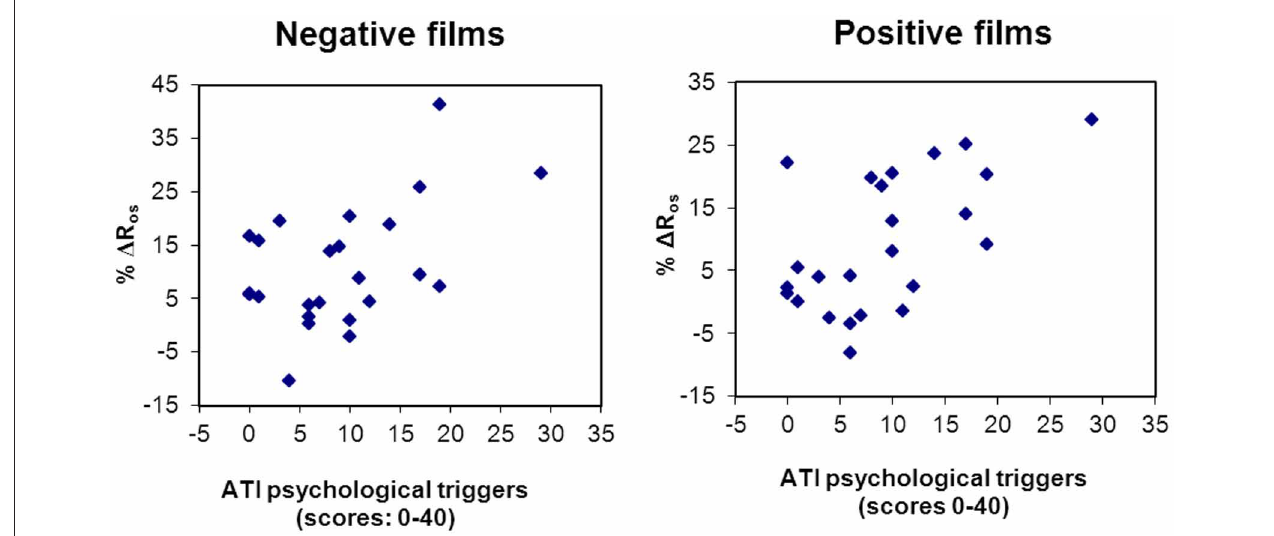
FIGURE 3 | Scatter plots of the association between self-report of asthma emotional triggers in daily life and respiratory resistance change to laboratory emotion-induction using films of a negative ( r = 0 . 48, p = 0 . 017) and positive ( r = 0 . 58, p = 0 . 003) emotional valence (Ritz et al.,